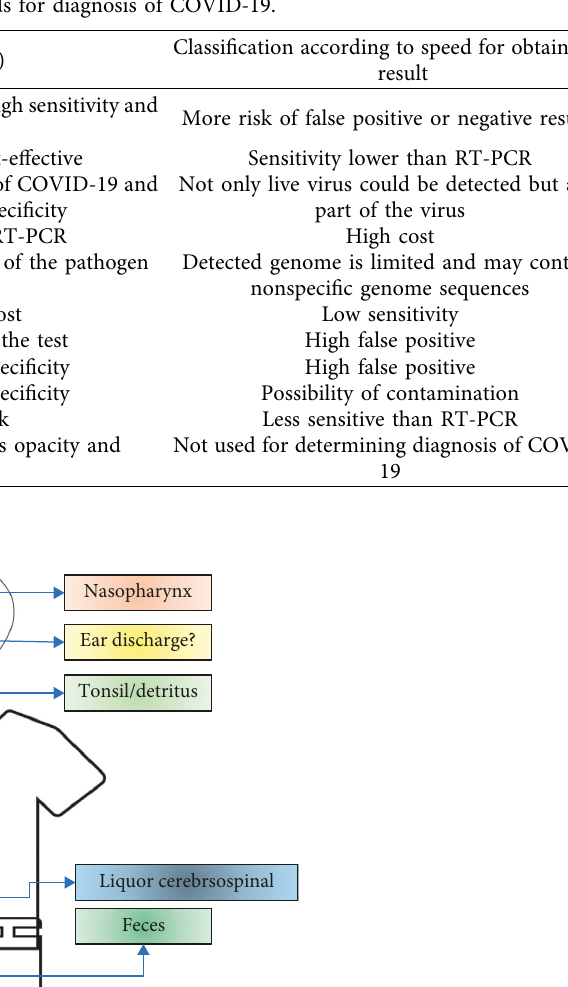
Table 1: Profile of methods for diagnosis of COVID-19.